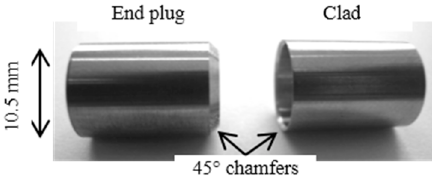
Figure 1. Pieces to be welded: end plug and clad.